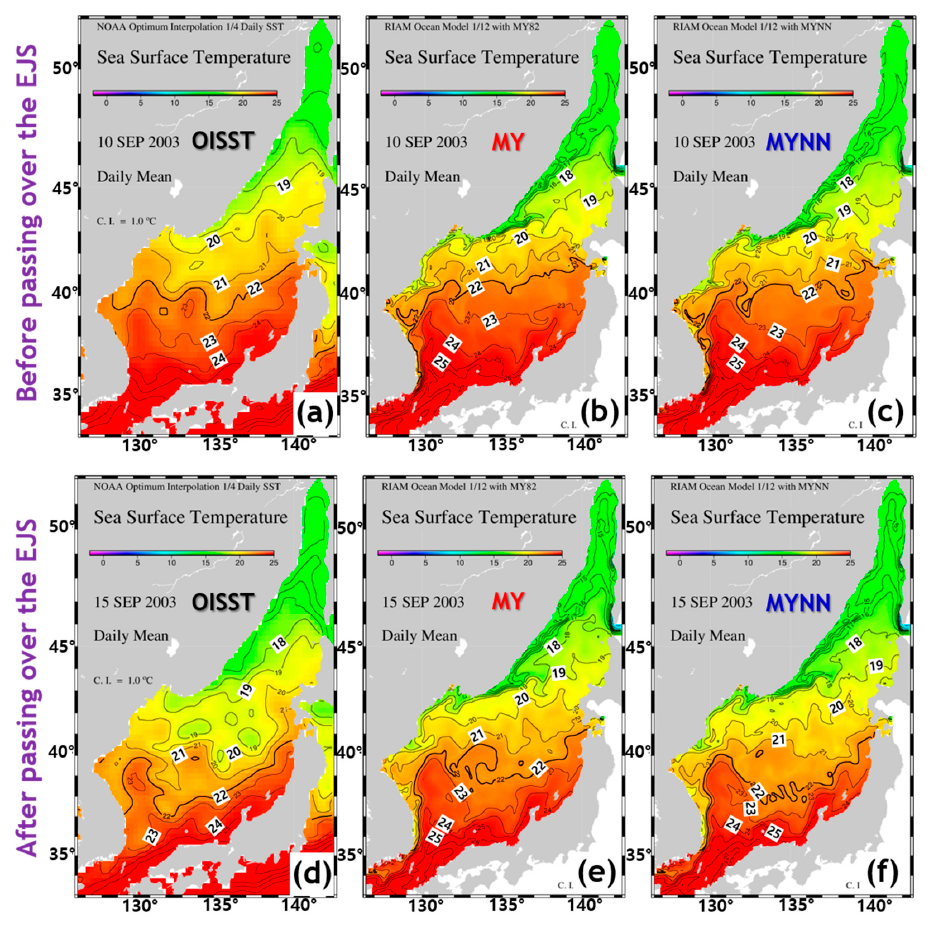
Figure 3. Sea surface temperature horizontal distributions obtained from ( a , d ) Optimum Interpolation Sea Surface Temperature (OISST) and simulated using ( b , e ) Mellor–Yamada (MY) model and ( c , f ) Mellor–Yamada–Nakanishi–Niino (MYNN) model before (top row) and after (bottom row) Typhoon Maemi. The thick contour line in each panel indicates a 22 ˚ C isotherm. The contour interval is 1 ˚ C.